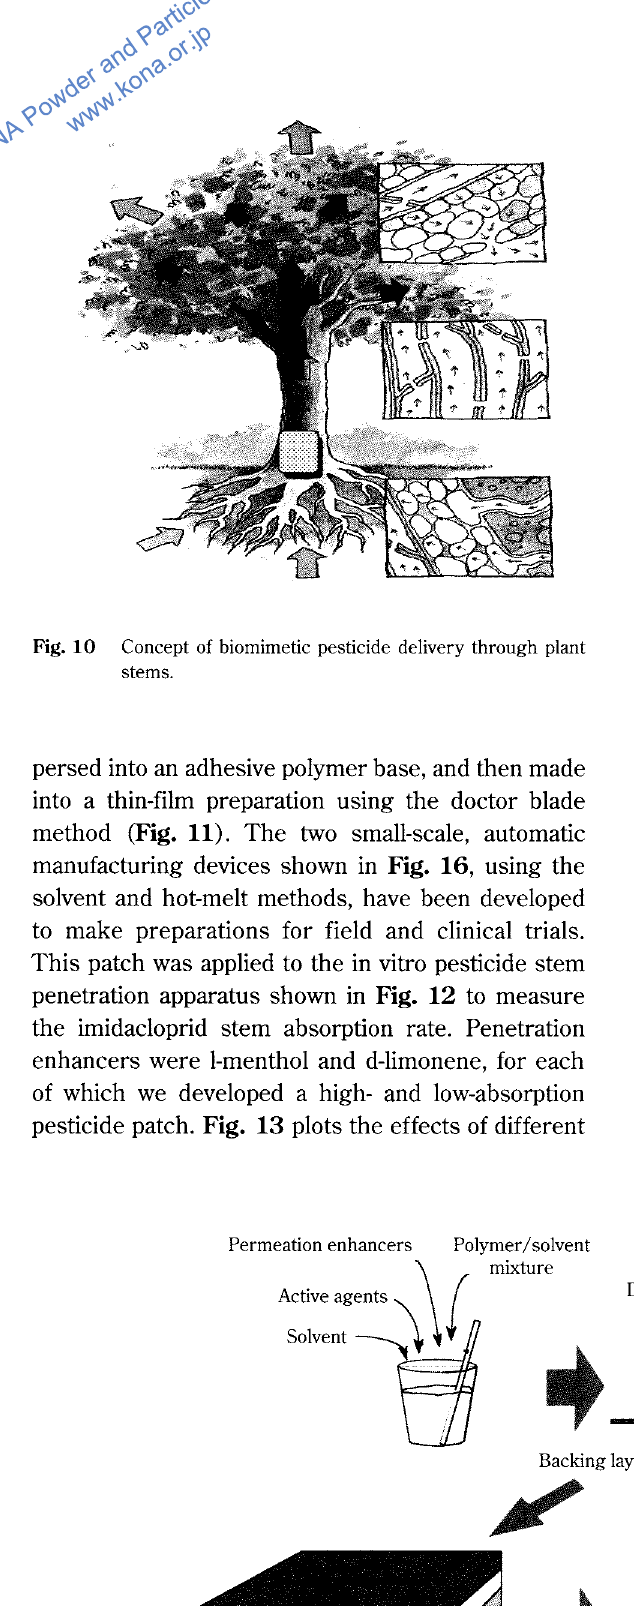
Fig. 11 Laboratory process for manufacturing pesticide